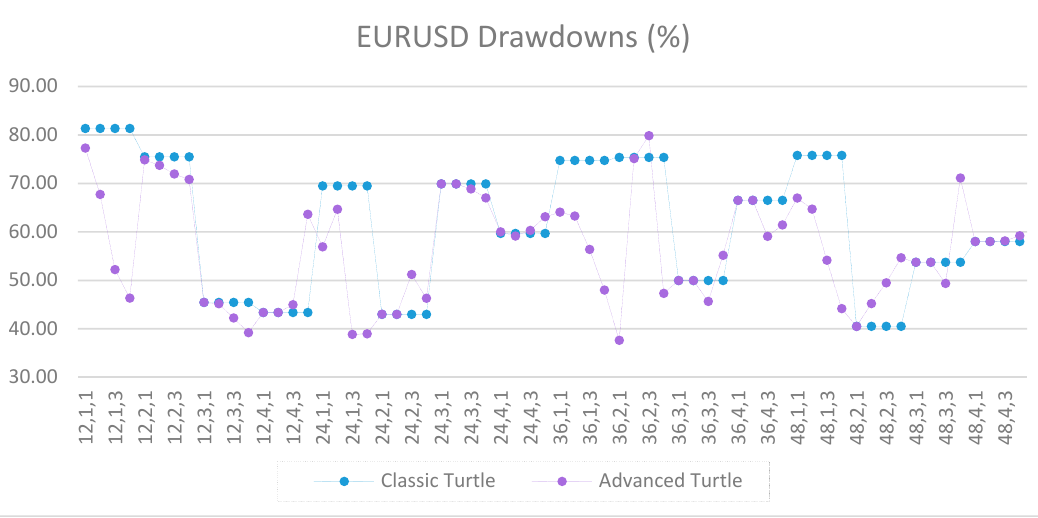
Figure A36. Drawdowns of EURUSD as percentage of equity between the classic and the advanced Turtle systems for every combination of N, X, Y for the slow parameters (80, 160).